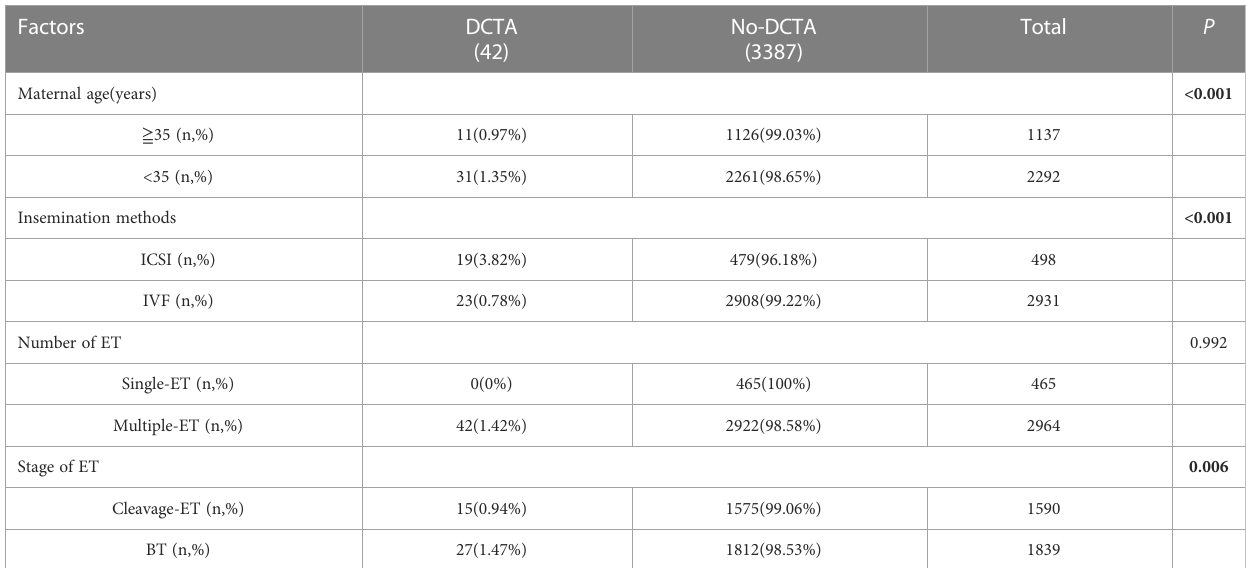
ET, embryo transfer; ICSI, intracytoplasmic sperm injection; IVF, in vitro fertilization; BT, blastocyst transfer. Bold values was statistically signi fi cant ( P <0.05).